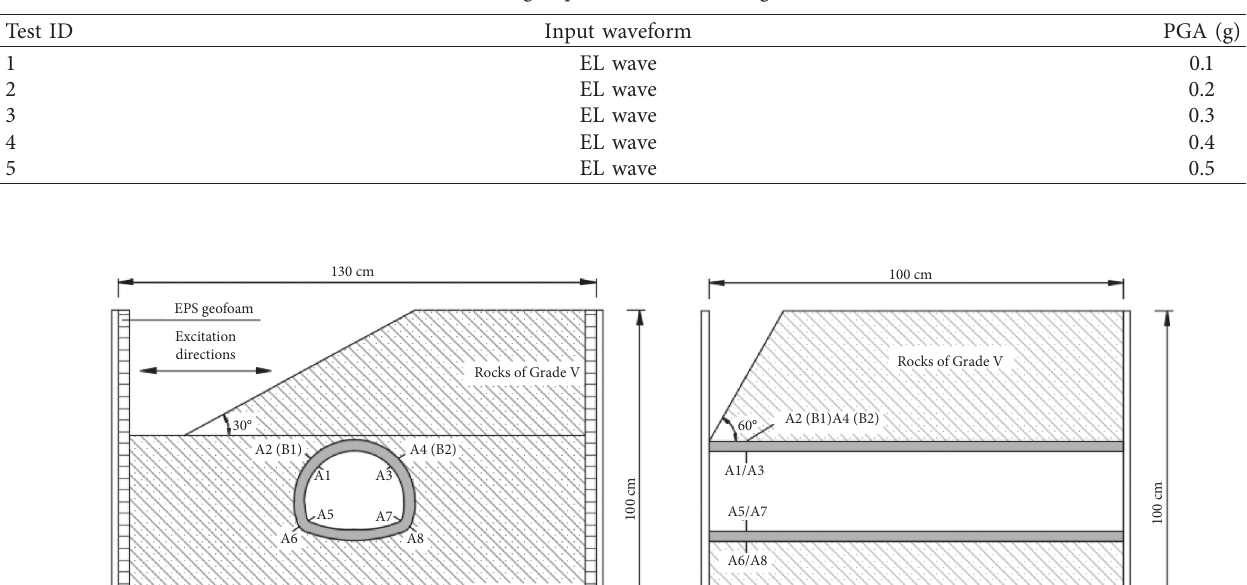
Table 4: Loading sequence for the shaking table tests.